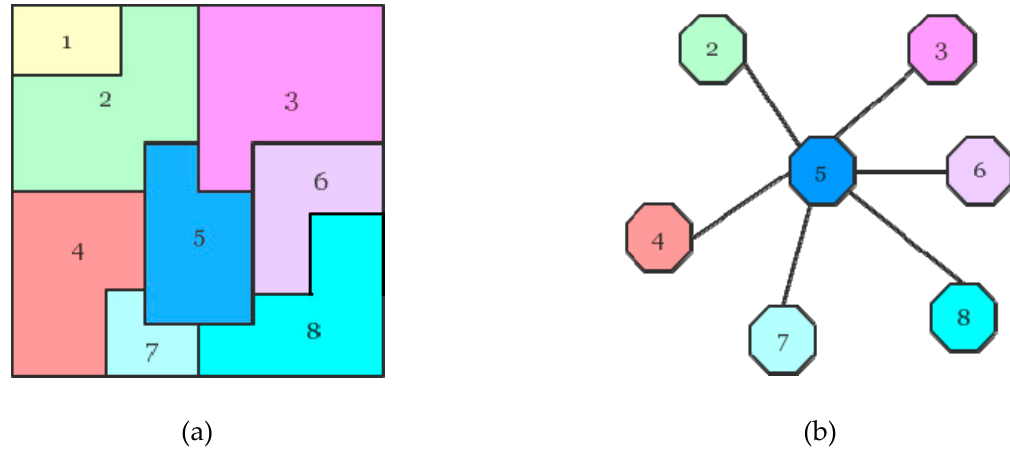
Figure 3. Schematic representation for a region neighborhood. ( a ) Segmentation result. ( b ) The neighborhood system for Region 5.